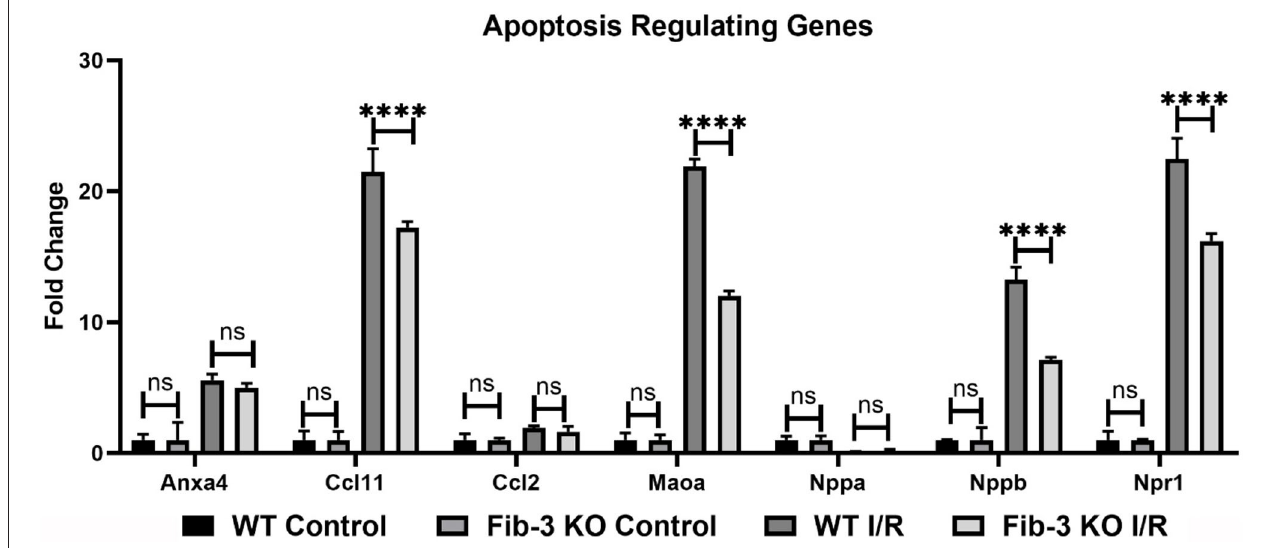
FIGURE 8 | Changes in apoptosis regulating genes in WT and Fib-3 KO CSs following I/R injury. Relative expression of Anxa4, Ccl11, Ccl2, Maoa, Nppa, Nppb and Npr1 in WT and Fib-3 KO CSs. Two-way ANOVA with Sidak’s multiple comparison test, p > 0.05 = ns and p < 0.0001 = **** . Error bars represent the mean ± SD ( n = 4).